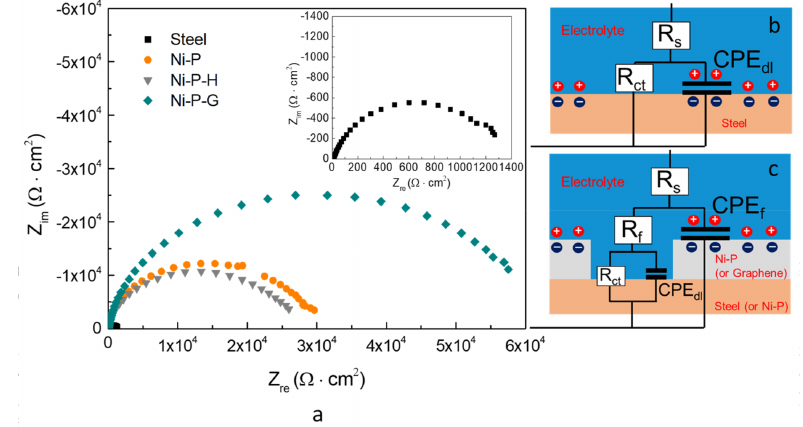
Figure 4. Nyquist plots of the Q235 steel, Ni–P, Ni–P–H, and Ni–P–G at the immersion time of 2 h in 3.5 wt % NaCl solution ( a ) and the equivalent circuits for the Q235 steel ( b ) and the three type of coatings ( c ).